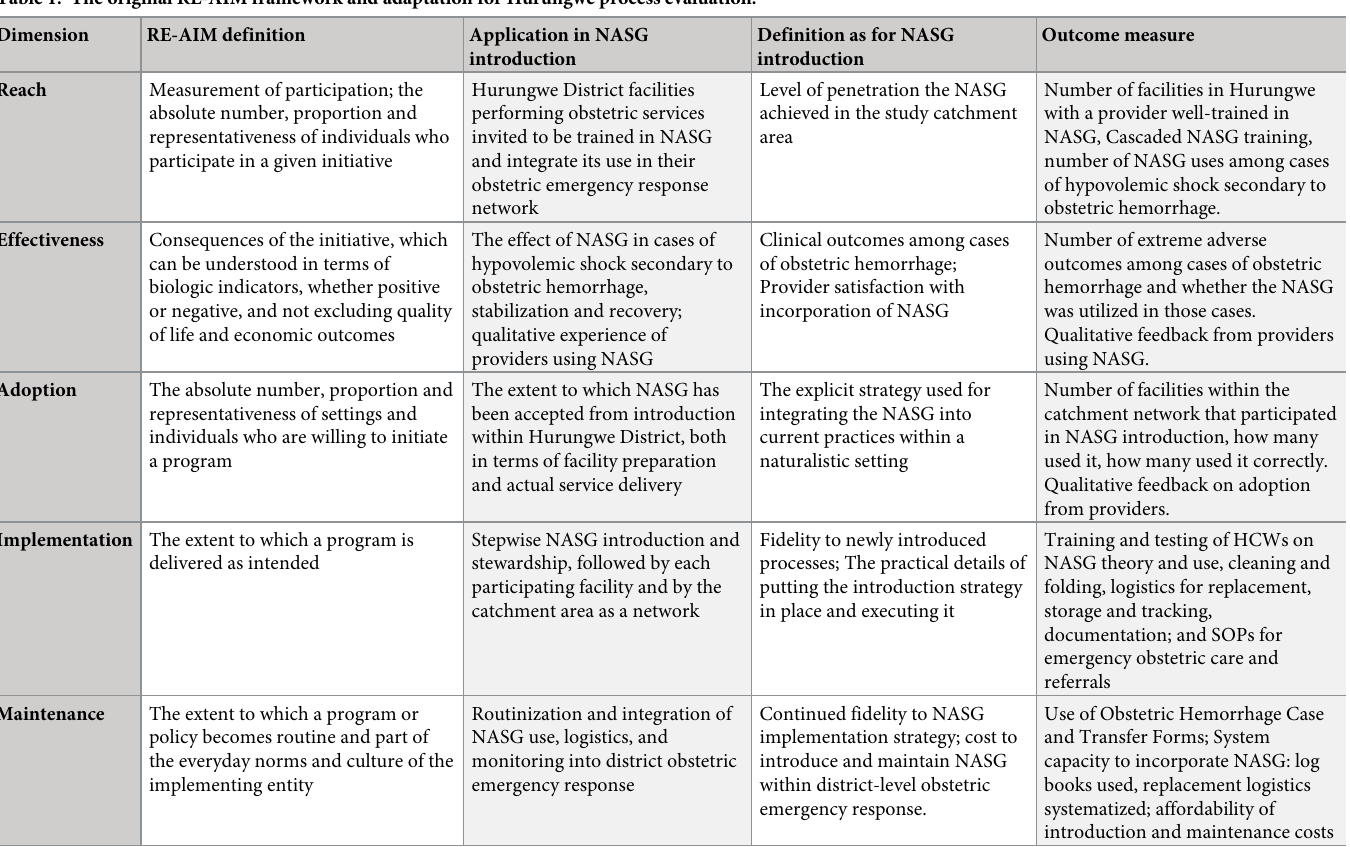
Table 1. The original RE-AIM framework and adaptation for Hurungwe process evaluation.